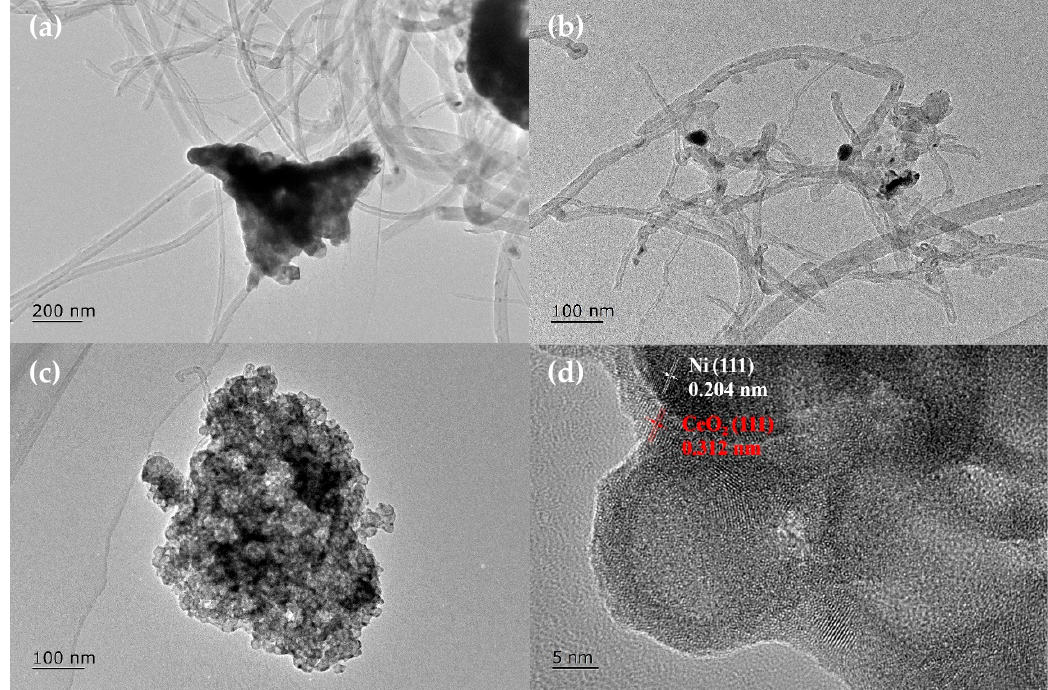
Figure 9. Transmission electron microscopy images of the used catalysts: ( a ) Ni-CeO 2 (SC), ( b )Ni-CeO 2 / SiO 2 (IM), and ( c , d ) Ni-CeO 2 / SiO 2 (CSC).